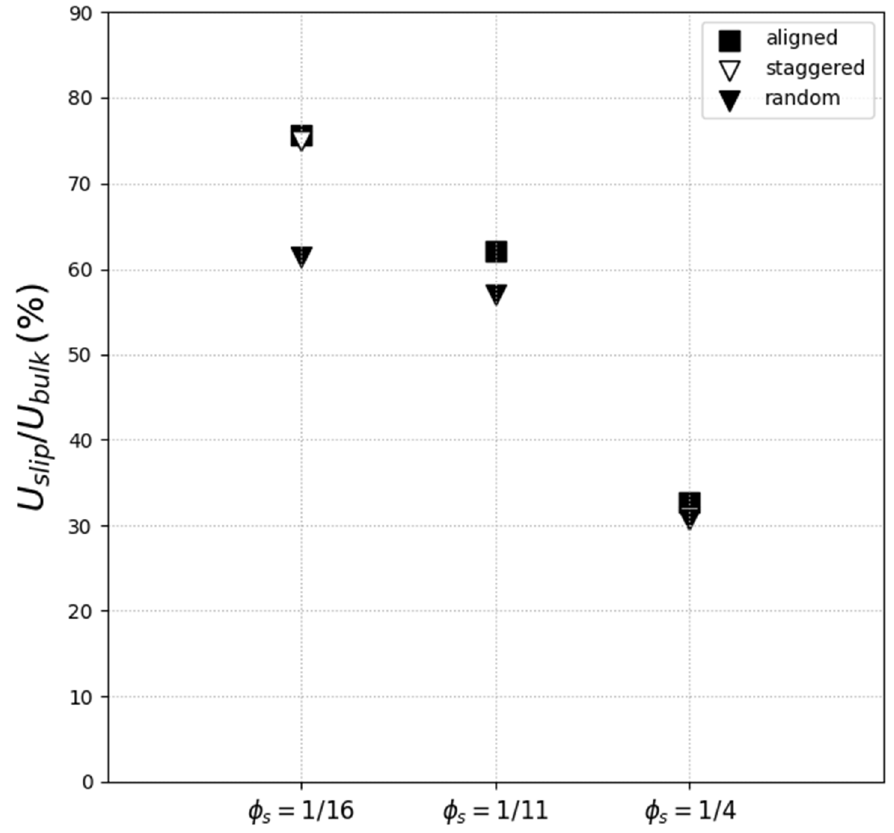
Figure 10. Slip velocity as a percentage of the bulk velocity for three different distributions of post types: ( ■ ) aligned, ( ▽ ) staggered, and ( ▼ ) random distribution.